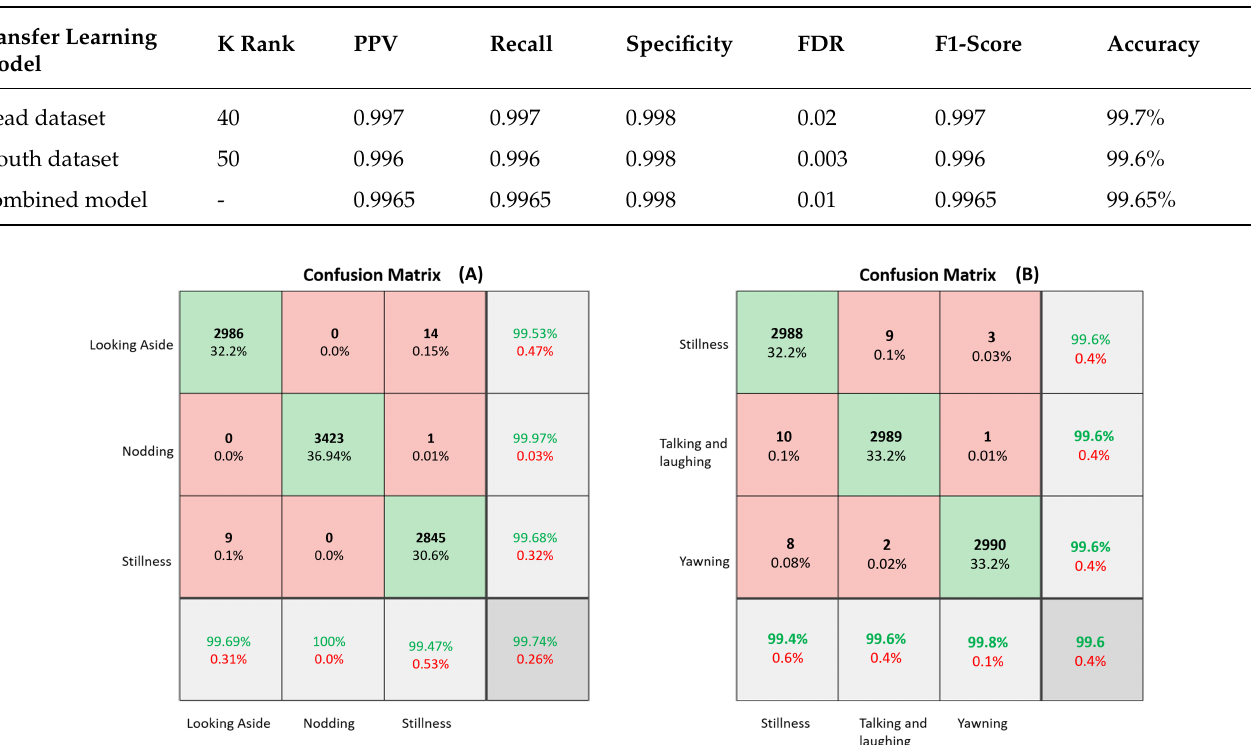
Figure 12. Training results of the feature extraction model for classifying ( A ) head position dataset and ( B ) mouth movement dataset. Table 10. Performance metrics of the SVM-based feature extraction model.